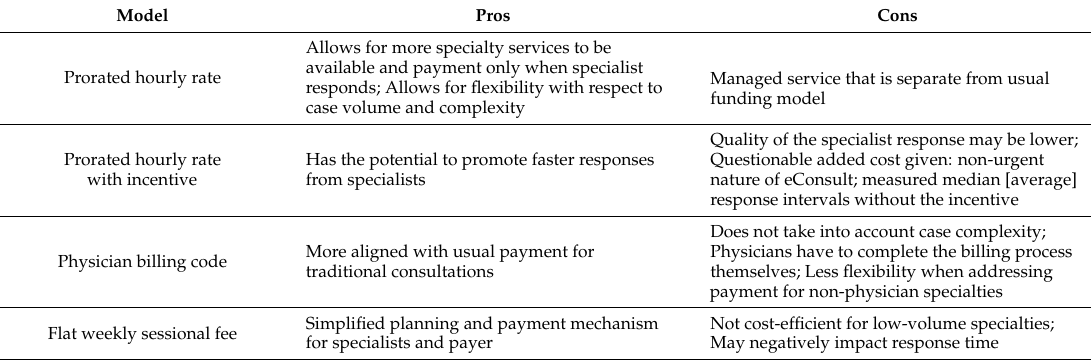
Table 4. Pros and cons to consider when deciding on which remuneration model to implement for